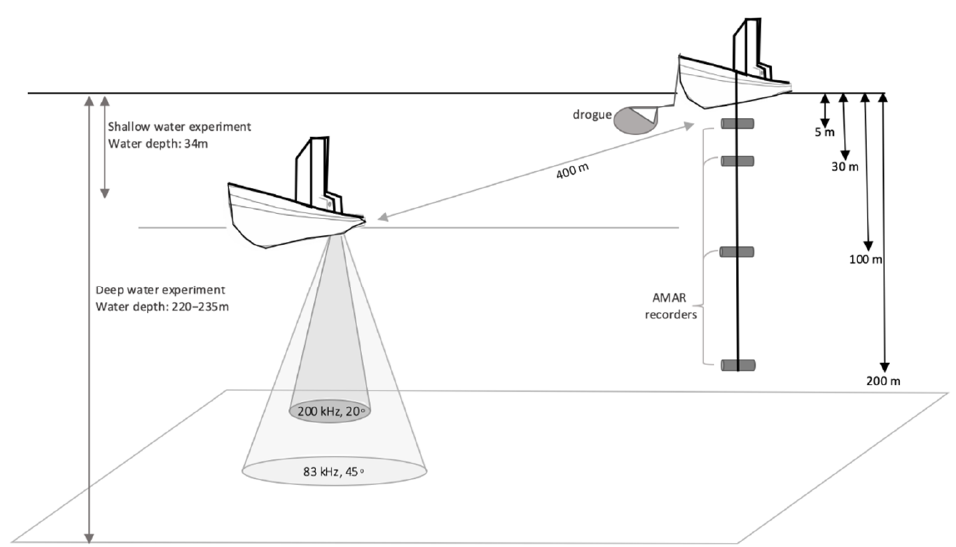
Figure 2. Experimental set-up for the deep-water (220–235 m depth) surveys with four AMARs suspended from the recording vessel and with the source vessel completing transects with either the 200 or 83 kHz signal at a maximum distance of 400 m. In shallower water (34 m depth), the recording vessel was anchored instead of using the drogue shown in the figure.